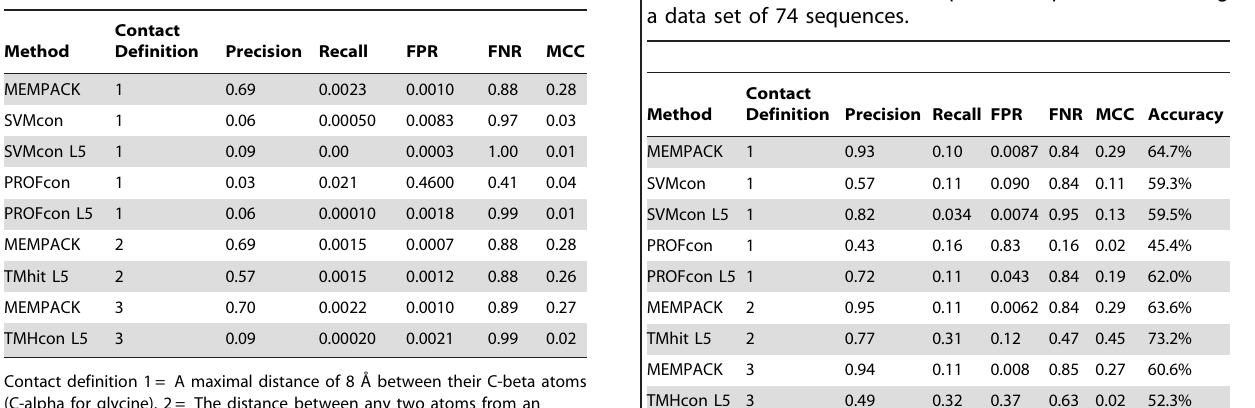
Table 3. Helix-helix interaction prediction performance using a data set of 74